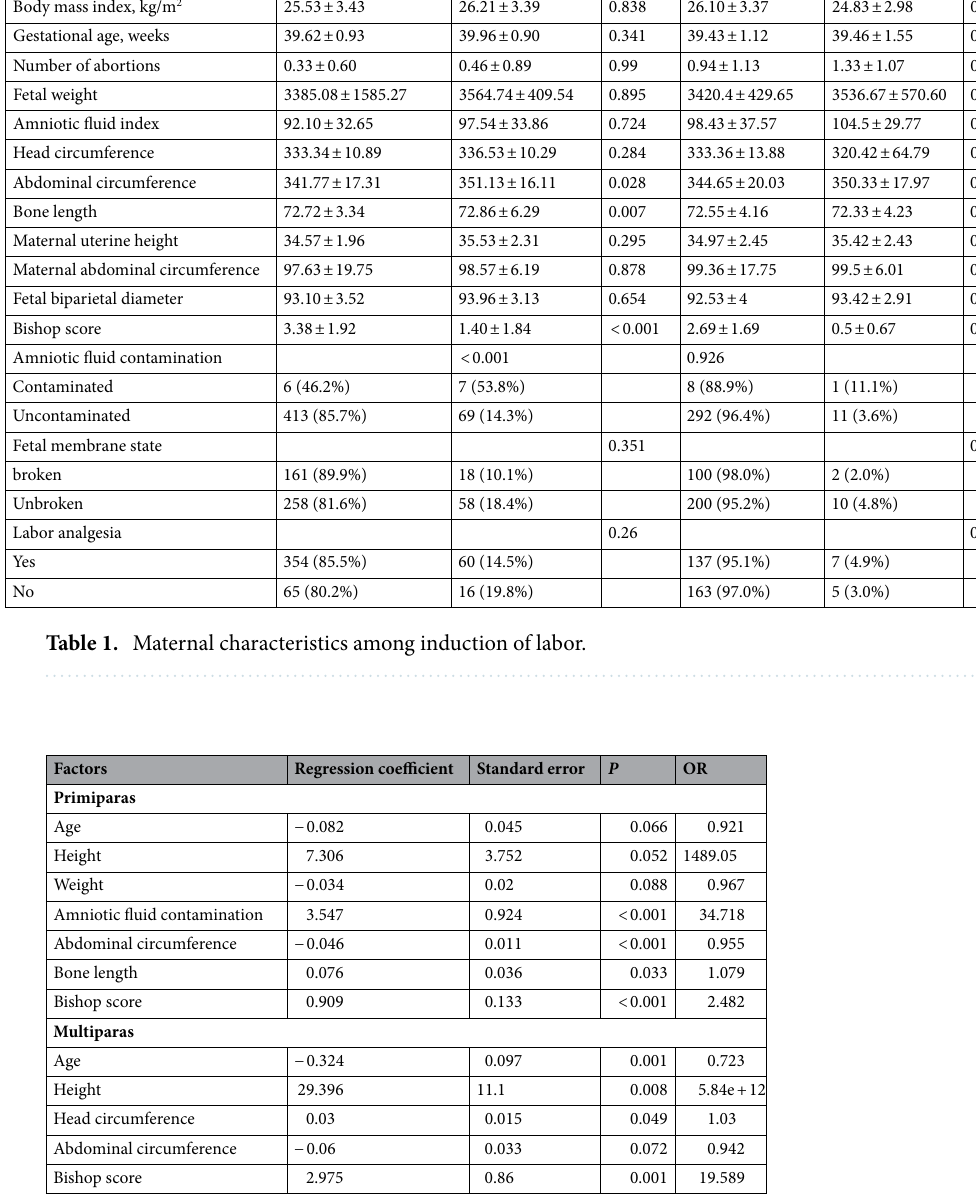
Table 2. Results of multivariate logistic stepwise regression